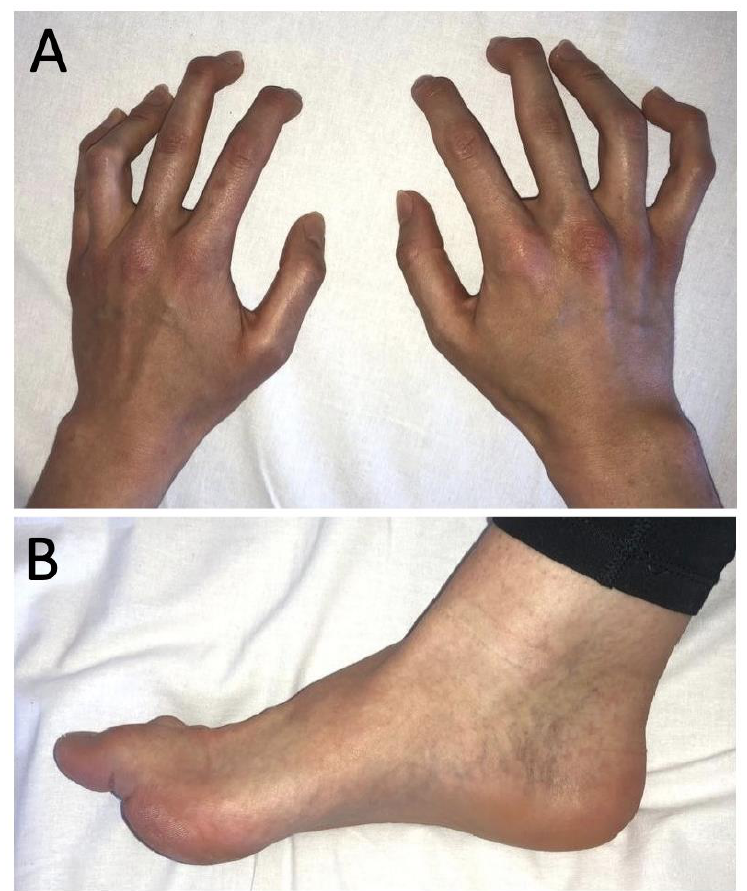
Figure 1. Clinical findings nine years after first manifestation of neuromyotonia. ( A ) Bilateral swan- neck deformities of fingers. ( B ) Bilateral pes